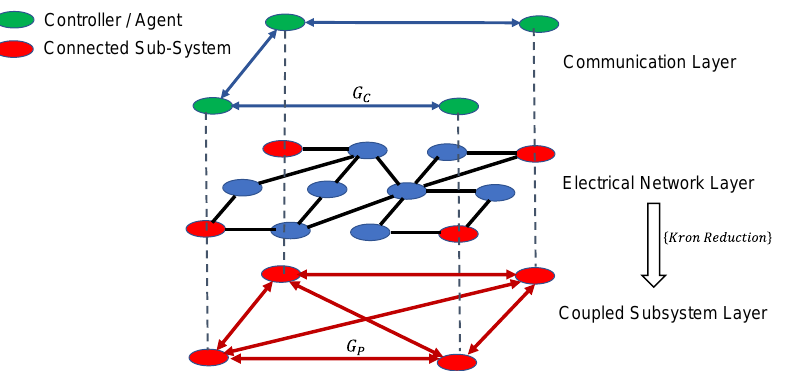
Figure 3. Cyber – physical layers in a cooperative microgrid. Figure 3. Cyber–physical layers in a cooperative